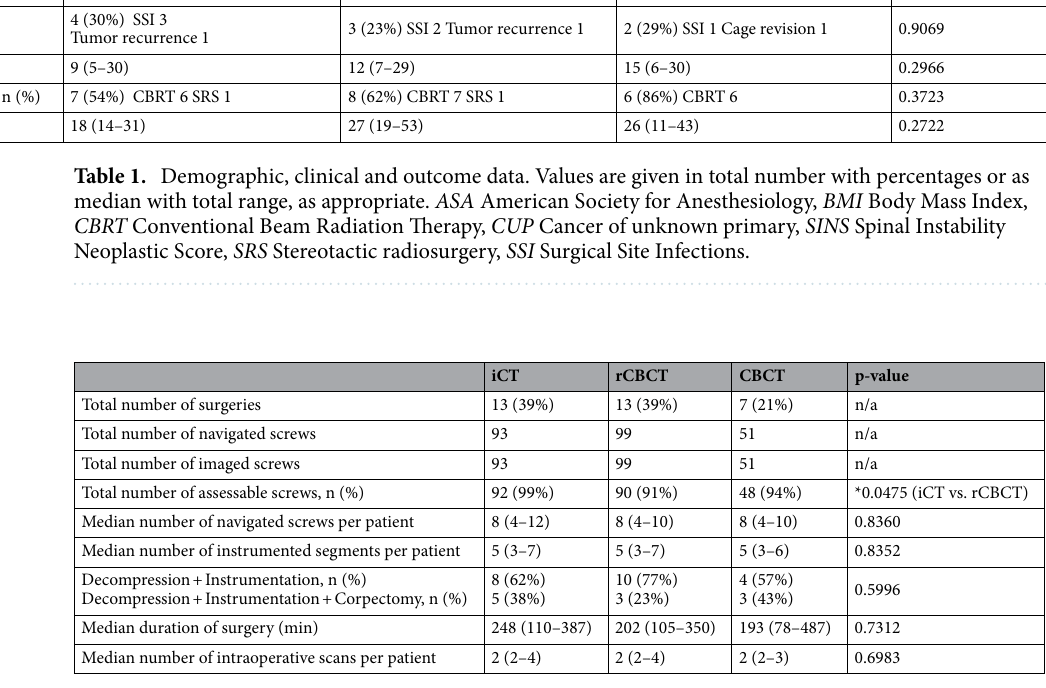
Table 2. Surgical data depending on the intraoperative imaging modality. Values are given in total number with percentage or as median with total range, as appropriate. iCT Intraoperative CT, rCBCT robotic cone beam CT, CBCT cone beam CT, n/a not